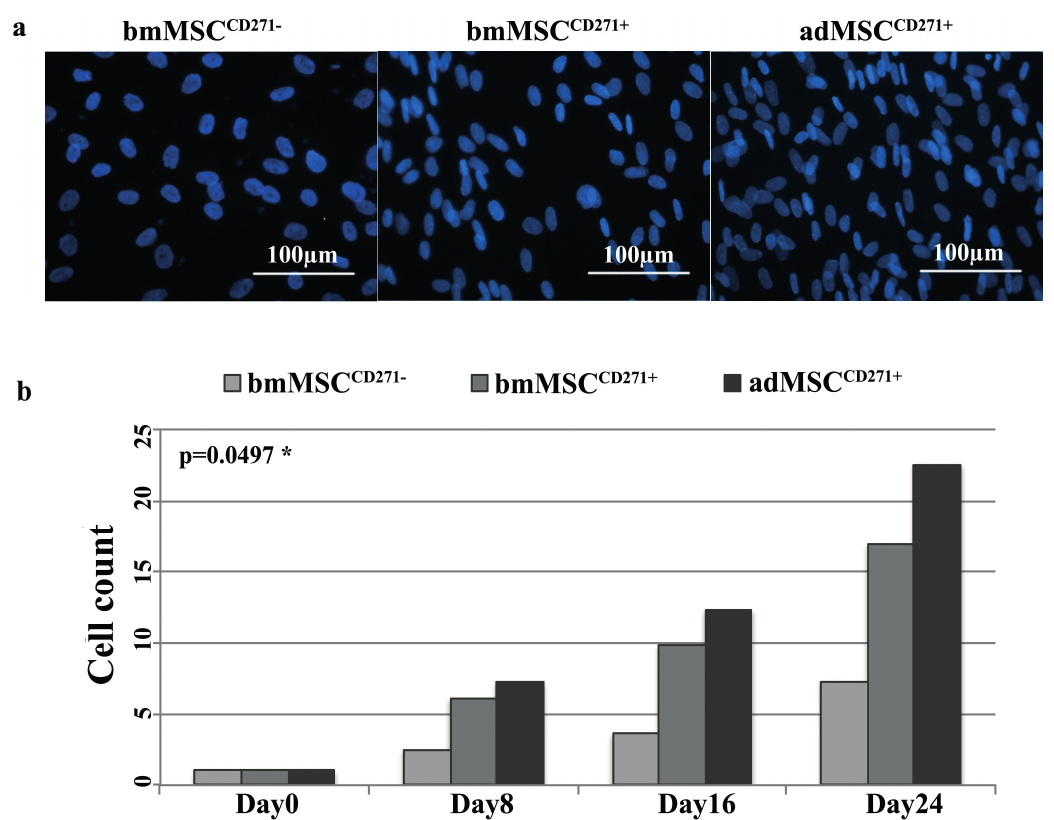
Figure 2. DAPI staining showing the cell density at different time points after osteogenic differentiation. ( a ) Representative DAPI staining of bmMSC CD271 − , bmMSC CD271+ and adMSC CD271+ at the 24th day of differentiation; ( b ) Similarly, cell count shows statistically significant differences among cell lines at day 8, 16 and 24 ( p = 0.0497). In particular, data clearly show that CD271 + MSCs have a higher proliferation rate as compared to CD271 − MSCs, with statistical significance maintained in adMSC CD271+ vs. bmMSC CD271 − pairwise comparison ( p = 0.0381). * p <